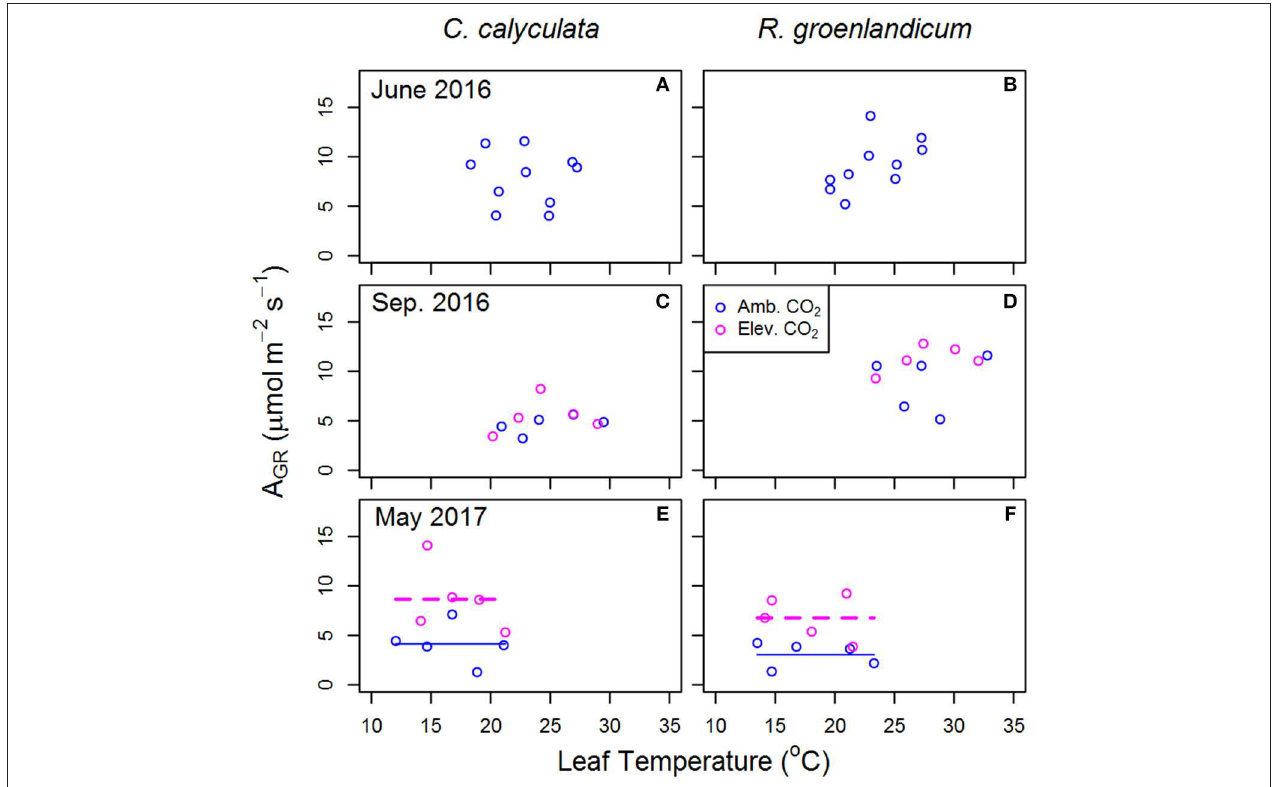
FIGURE 3 | Mean net photosynthesis per unit leaf area at saturating light ( A GR ) for two shrub species at the SPRUCE site in each plot, for newly expanded ( A,B ; June 2016), mature ( C,D ; September 2016), and overwintered ( E,F ; May 2017) leaves vs. mean measured leaf temperature. Leaf temperature and chamber [CO 2 ] were targeted to growth conditions of each plot. Elevated atmospheric [CO 2 ] treatments ( + 500 ppm) began the week following the June 2016 measurements. Lines indicate fit of best model, as evaluated using Akaike Information Criterion corrected for sample size (AICc). Panels without lines have intercept-only best models as shown in Table 1